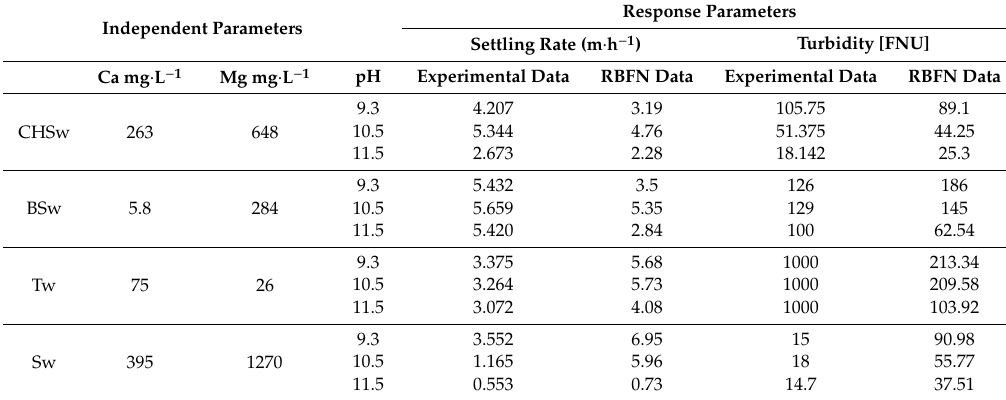
Table 10. Comparison between experimental data and those predicted by the Radial Basis Function Network